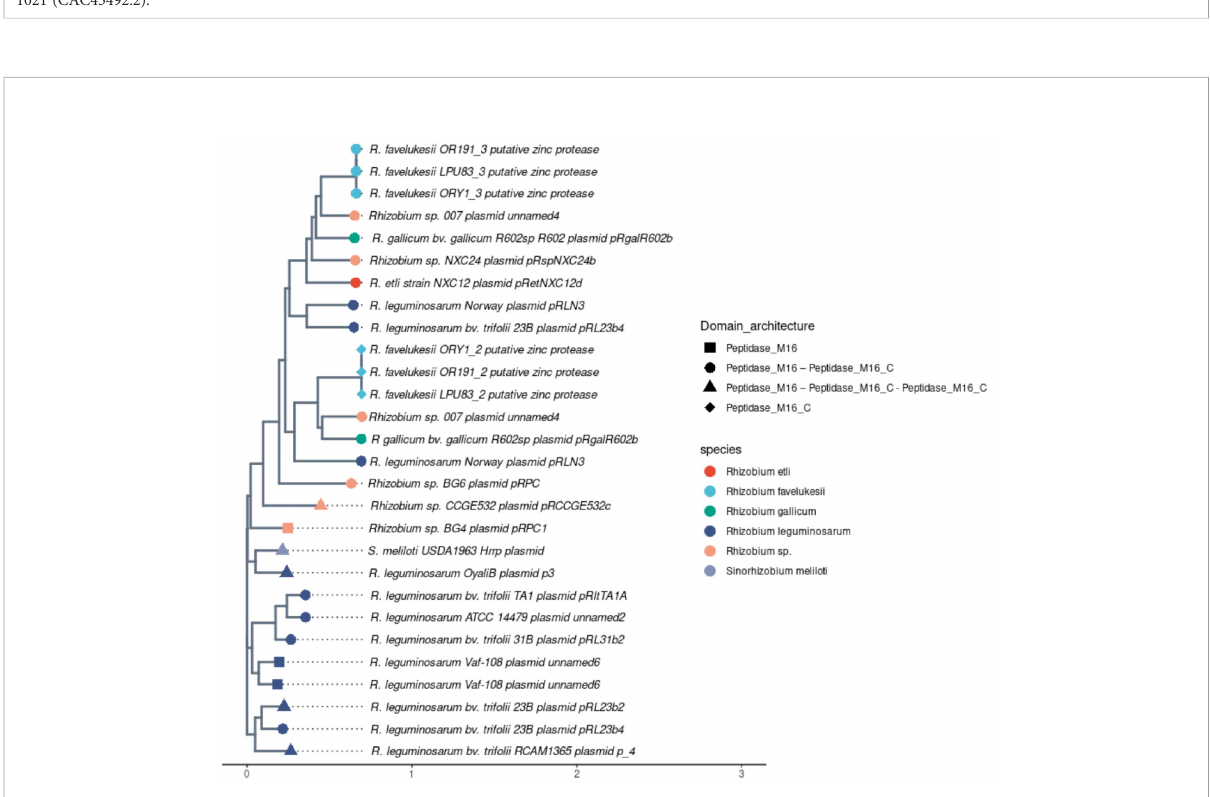
FIGURE 4 Phylogenetic tree of M16 peptidase sequences encoded in plasmids of different rhizobia species. The phylogenetic tree of peptidase sequences was computed with Neighbourg-Joining algorithm. Tip colours indicate the rhizobium host species. Tip shapes indicate different domain architectures, which were manually browsed in the Pfam web server for each peptidase